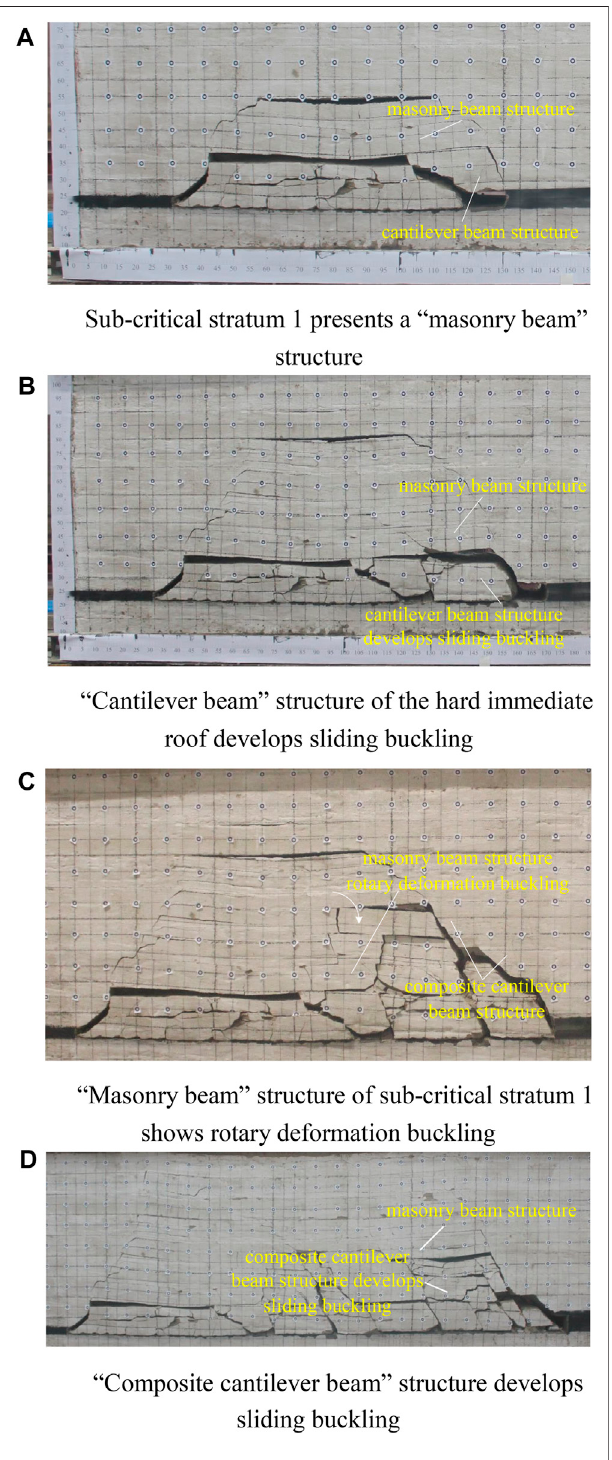
FIGURE 8 | Structural evolution model of the critical strata. (A) Sub- critical stratum 1 presents a “ masonry beam ” ; (B) “ Cantilever beam ” structure of the hard immediate roof develops sliding buckling; (C) “ Masonry beam ” structure of sub-critical stratum 1 shows rotary deformation buckling; (D) “ Composite cantilever beam ” structure develops sliding